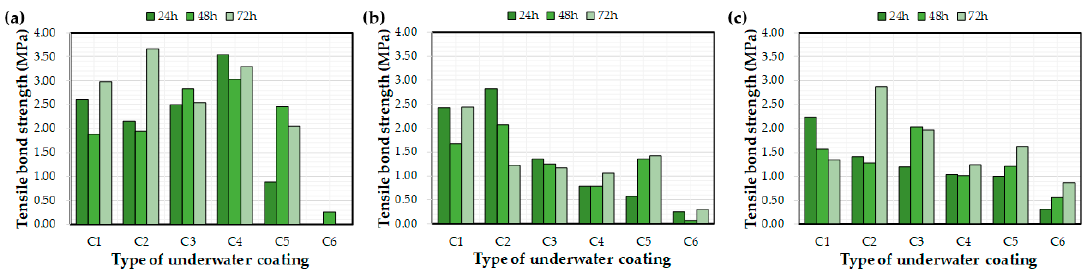
Figure 10. Effect of the water exposure time on the measured bond strength: ( a ) control, ( b ) E1, and ( c ) E2.